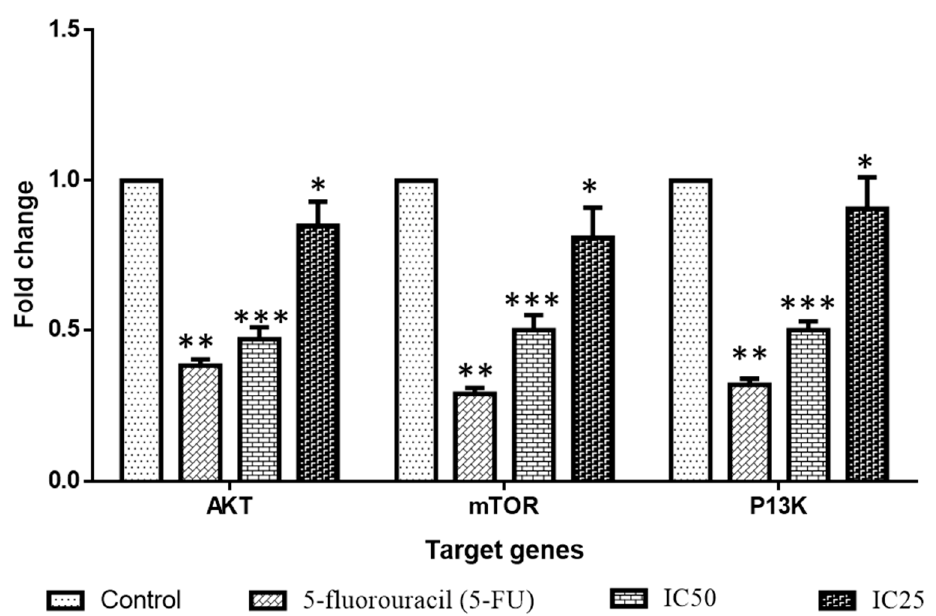
Figure 11. Effect of albumin and visnagin NPs on the PI3K/AKT/mTOR pathway in MDA-MB-468 cells. Values were presented as mean ± SD of the three samples. Data are analyzed by one-way ANOVA and Tukey postdoc assay using SPSS software. *** p < 0.0001 compared with control, ** p < 0.005 compared with control, * p < 0.05 compared with control.